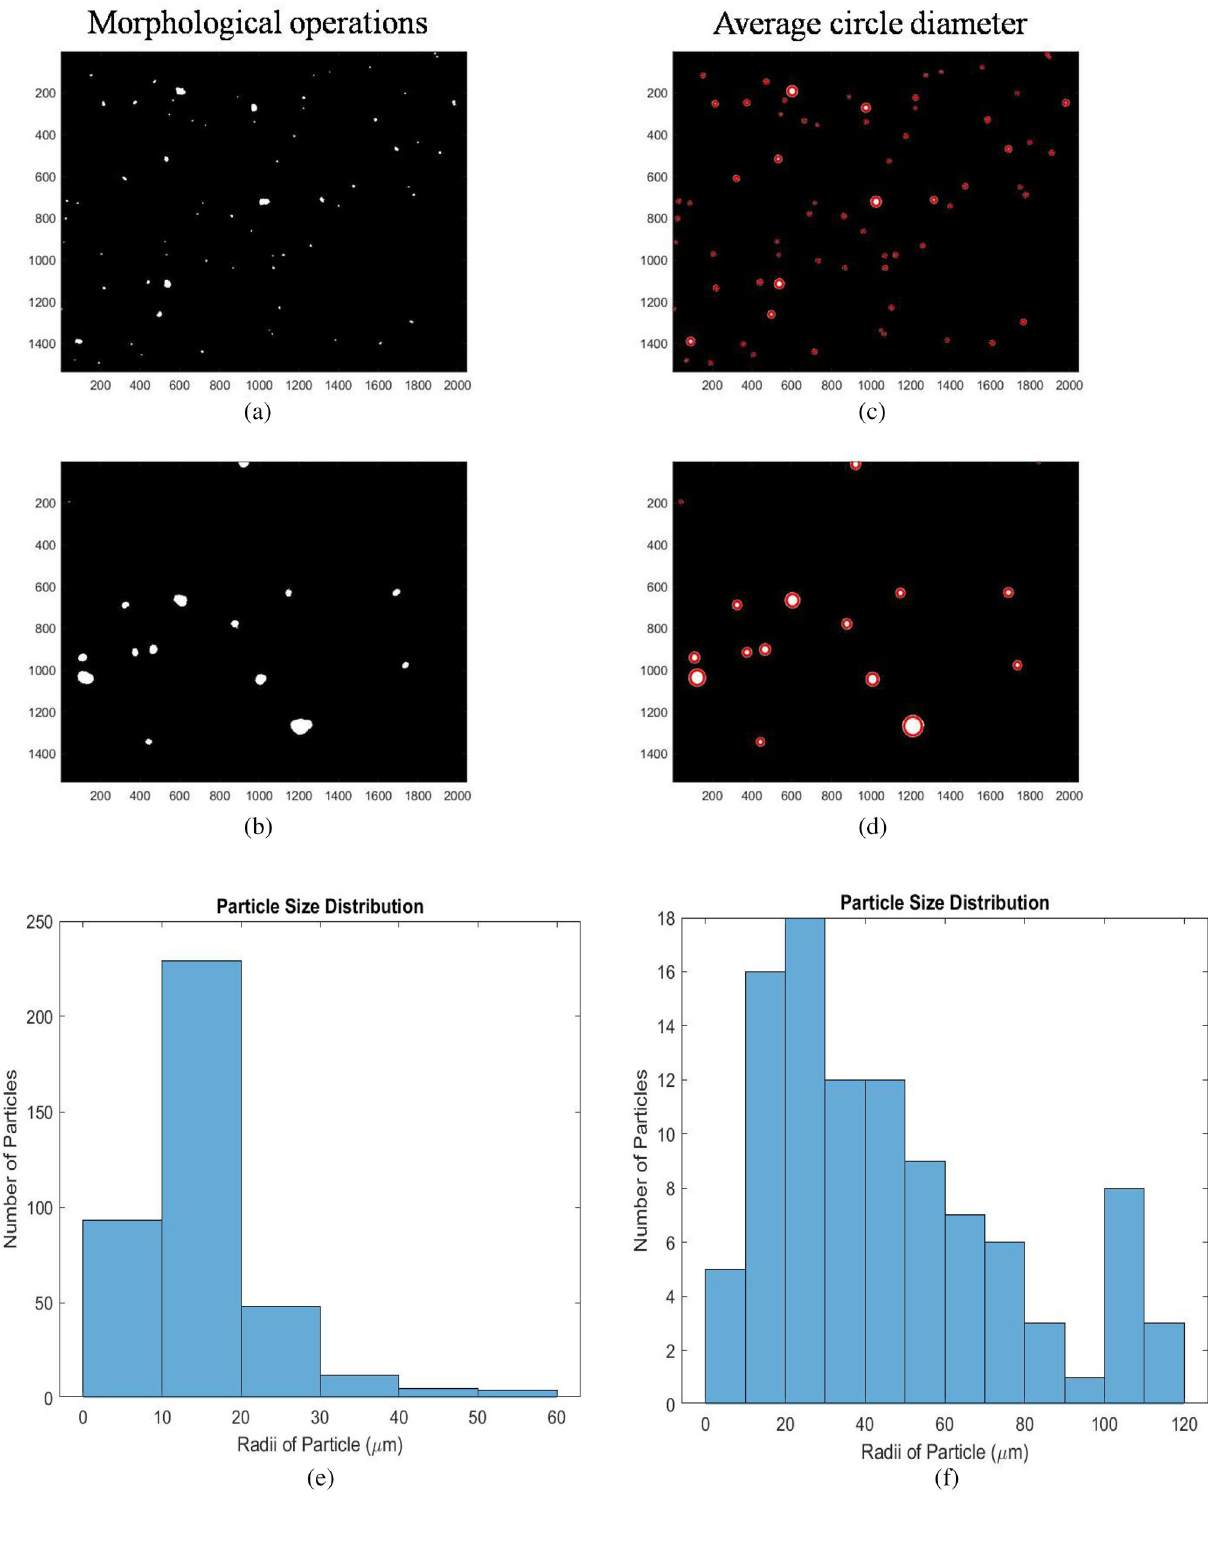
Figure 10. ( a ) and ( b ) are the output after performing morphological operations on Fig. 4b,c. ( c ) and ( d ) shows the images with circles of the corresponding particle’s circularity drawn over the particles. ( e ) and ( f ) shows the c omparison of size distribution data of aggregates in serum obtained at 24 and 48